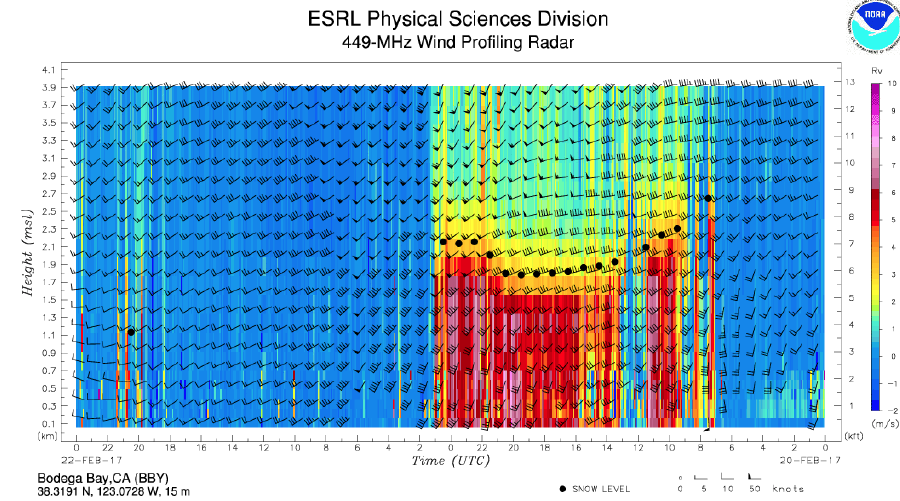
Figure 8. Profiler data from Bodega Bay (northern side of SFBA) for 20–22 February 2017. Black dots indicate a bright band (BB) level around 1.9–2.2 km during the AR event.